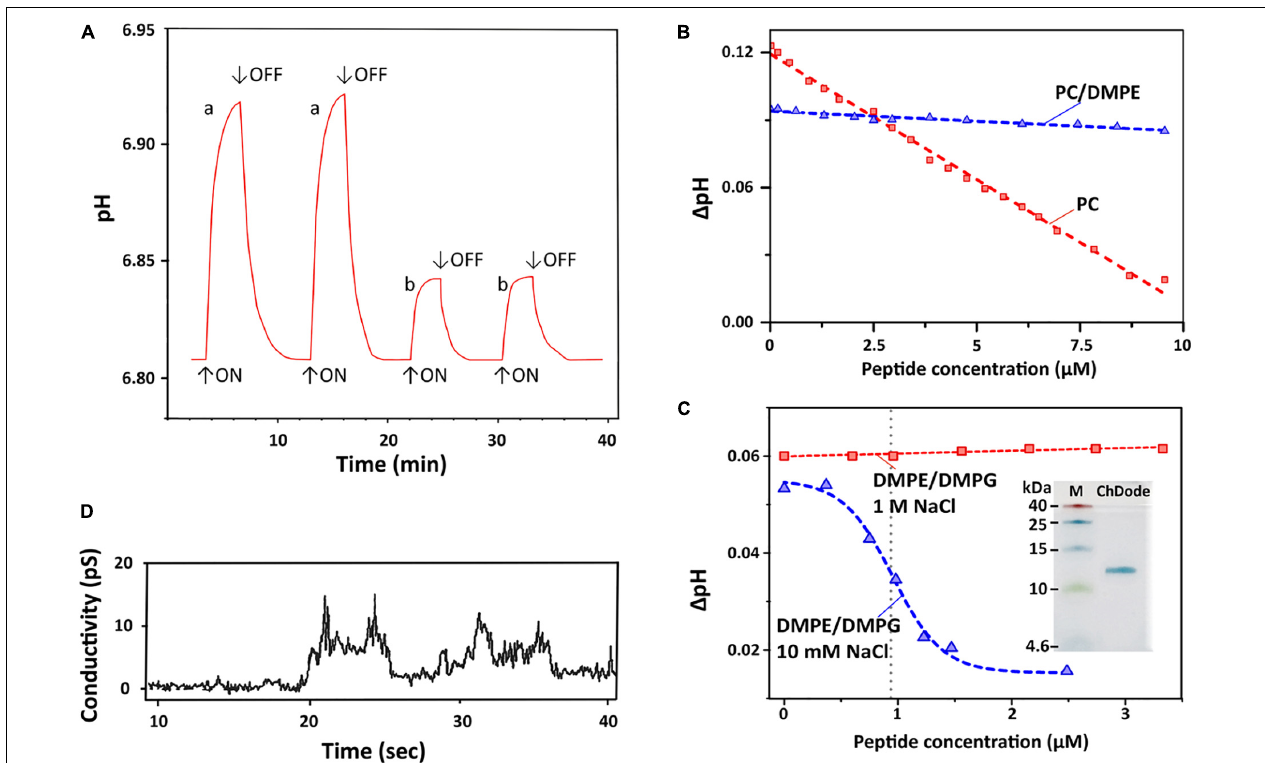
FIGURE 7 | Proton transfer activity and permeabilization of planar lipid membrane. (A) Time course of light-induced pH changes in the unbuffered suspension (1 M NaCl, 25 ◦ C) of BR-proteoliposomes prepared from soybean PC without (a) and after an addition of 7 µ M ChDode dimer (b). The arrows indicate time when illumination is turned on or off. Minimum 3 min pause after the peptide addition is necessary to reach the pH equilibrium and obtain reproducible results. (B) Dependence of light-induced pH changes ( (cid:49) pH) on the dimeric peptide concentration in PC (red) and PC/DMPE (1:1, blue) liposomes (1 M NaCl). (C) Dependence of light-induced (cid:49) pH values on the dimeric peptide concentration in DMPE/DMPG (2:1) liposomes at two NaCl concentrations (10 mM and 1 M). The Hill equation ( y = B0 + (A0 – B0)/(1 + ([ChDode]/IC 50 ) nH )) was fitted to the data obtained at 10 mM. The calculated IC 50 and nH parameters were 0.95 ± 0.03 µ M and 4.6 ± 0.6. Insert: Tricine-SDS-PAGE of the recombinant ChDode (0.5 µ g). M, molecular mass marker. (D) Currents through a lipid bilayer membrane made of polar lipid extract from E. coli induced by 1.67 µ M ChDode dimer (5 mM HEPES, 20 mM NaCl, pH 7.4, applied voltage 50 mV). A heterogeneous population of conductance was